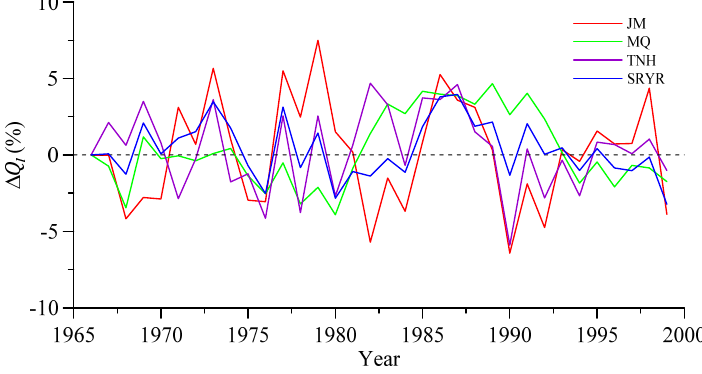
Figure 7. Time series of Δ Q l in the three sub‐basins and the source region of the Yellow River (SRYR).